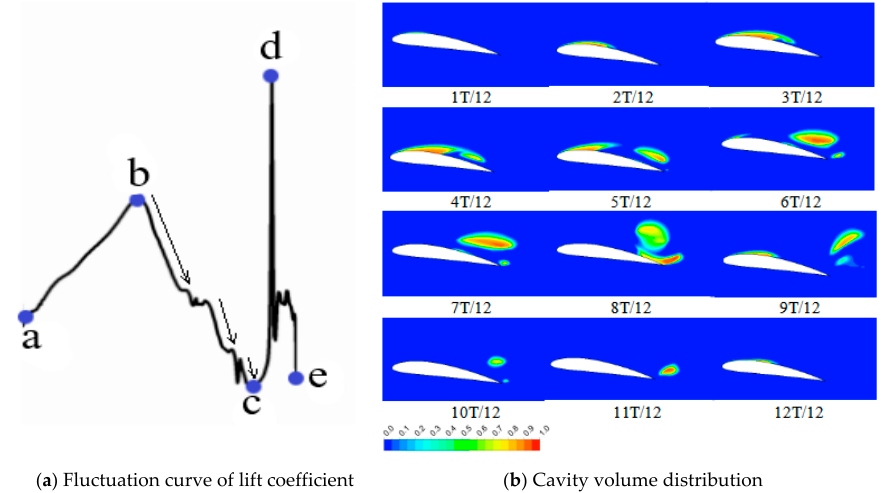
Figure 12. Fluctuation curve of lift coefficient and cavity volume distribution in one cycle ( α = 8°).